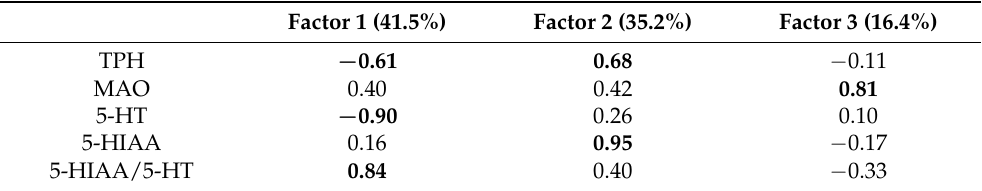
Table 3. Factor loadings for the 5-HT and 5-HIAA levels, the 5-HIAA/5-HT turnover rate and the TPH and MAO activities in the brain of 2-, 4- and 7-month-old male and female N. furzeri . Factor 1 (41.5%) Factor 2 (35.2%) Factor 3 (16.4%) TPH − 0.61 0.68 − 0.11 MAO 0.40 −